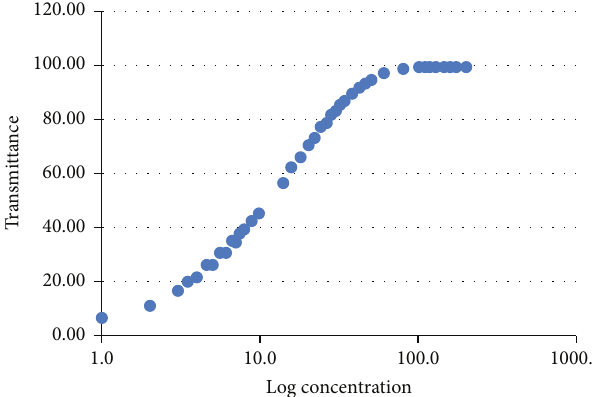
Figure 3: Ringbom curve for rifaximin working standard.